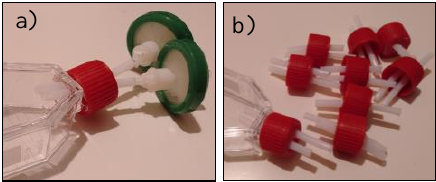
Table 1. Maximum shear stresses for various aspiration pipe shapes Model Maximum shear stress on the bottom wall of the container [Pa] for the flow rate 150 cm 3 /min for the flow rate 250 cm 3 /min